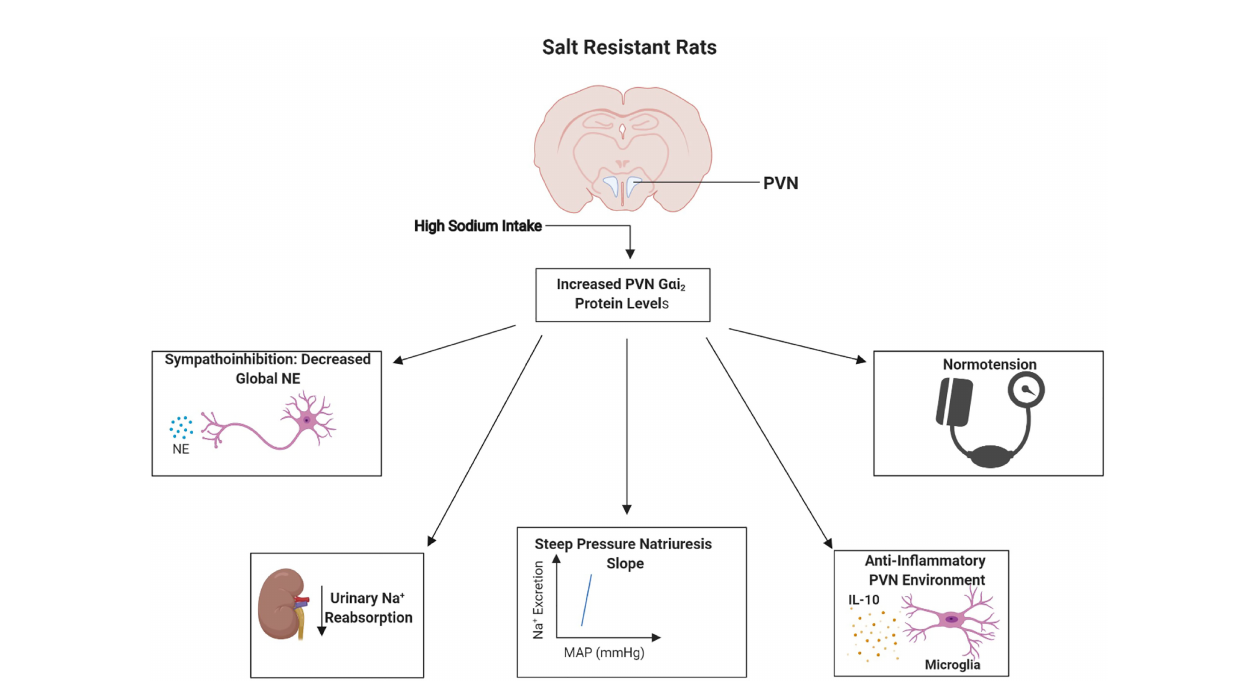
FIGURE 2 | Schematic representation of the proposed physiological role of paraventricular nucleus (PVN) G a i 2 proteins in salt resistance. In response to high dietary-sodium intake, upregulation of PVN G a i 2 proteins acts as peripherally sensed sodium-responsive “ anti-hypertensive ” pathway that mediates systemic sympathoinhibition, natriuresis and central anti-in fl ammatory responses to maintain normotension and a salt resistant phenotype. Image was generated using